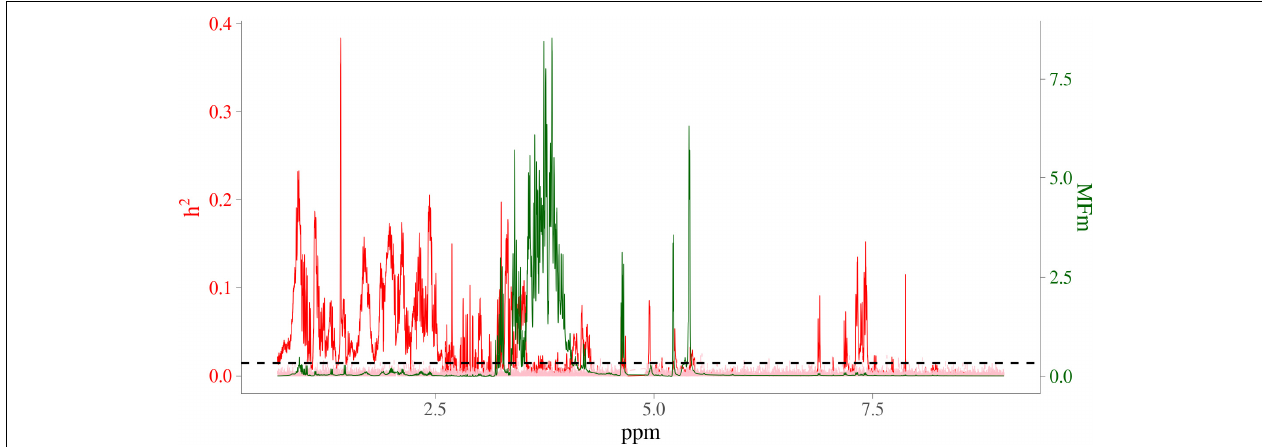
FIGURE 3 | Heritability and average NMR intensities for metabolomic features. Red line is heritability from real metabolomic features; pink line is the null distribution of heritability from simulated data all not residual variance assumed 0; green line is average NMR intensities (before centering and standardizing); horizontal dashed black line is the significant level at 1%; x -axis is NMR chemical shift (in ppm); red y -axis is heritability; green y -axis are the intensities of the NMR signals, which are proportional to the amounts of the metabolites that give rise to the signals.